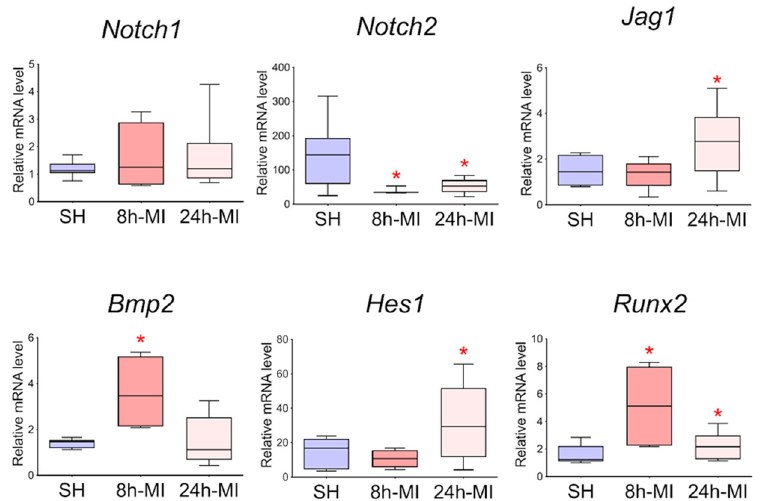
Figure 7. Dynamics of expression of Notch signaling pathway components and Bmp2/Runx2 genes in cardiac mesenchymal cells using quantitative PCR analysis. SH—cells from a healthy myocardium of sham-operated rats ( n = 3); 8 h-MI—post-infarction cells from rats 8 h after induction ( n = 4); 24 h-MI—post-infarction cells from rats 24 h after induction ( n = 9). Vertical—the relative amount of the mRNA in each group, measured by the 2 - ΔΔ CT method; box plots with whiskers at min to the max are presented. The asterisk shows significant differences between the SH and MI groups at p < 0.05 (unpaired nonparametric Mann–Whitney test).